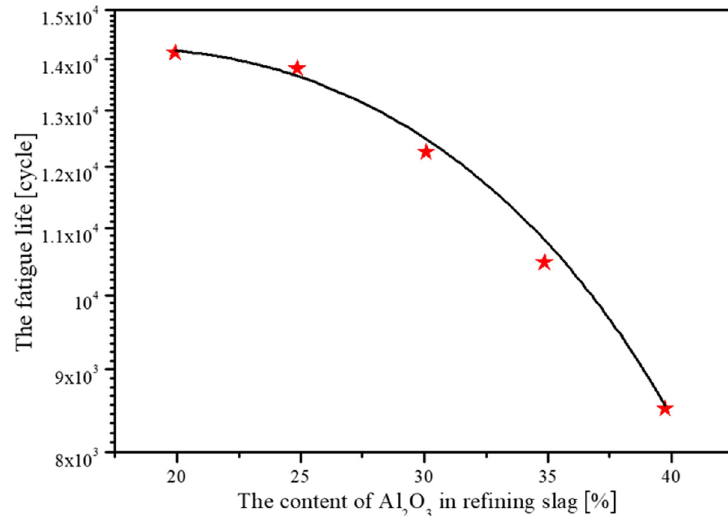
O content in slag and fatigue life of ULC automotive steel. 2 3